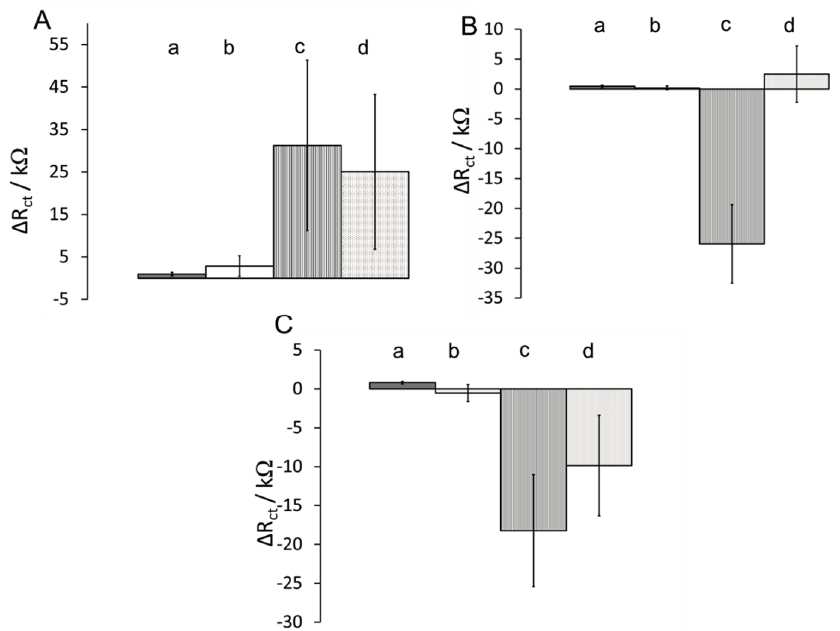
Figure 7. Plot of change in R ct as a function of protein solution during ( A ) CD13; ( B ) BSA; and ( C ) mucin protein adsorption on VLGXE-Au with various surfaces: (a) ethanolamine/2-mercaptoethanol, (b) ethanolamine/hexanethiol, (c) n-butylamine/hexanethiol, (d) n-butylamine/2-mercaptoethanol (protein concentration was 10 µg·mL − 1